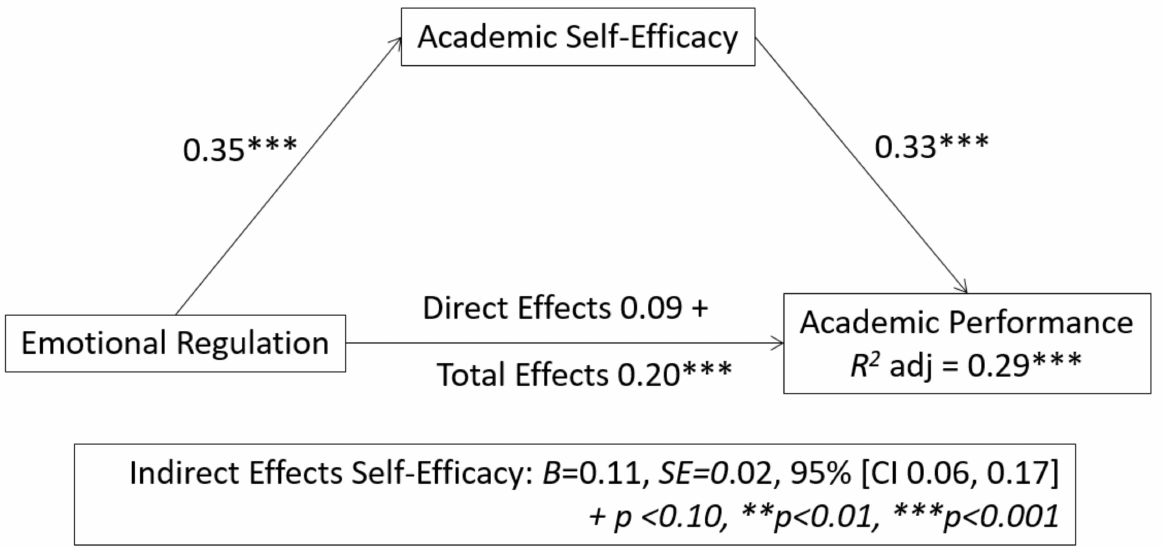
Figure 1. Mediating role of self-efficacy in the relationship between emotional regulation and academic